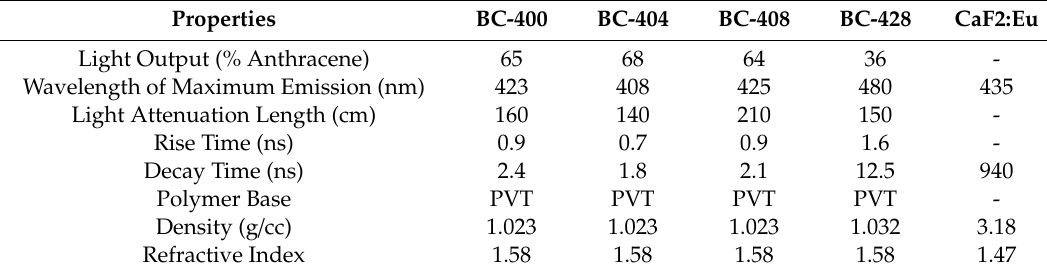
Table 5. Characteristics of plastic scintillator.